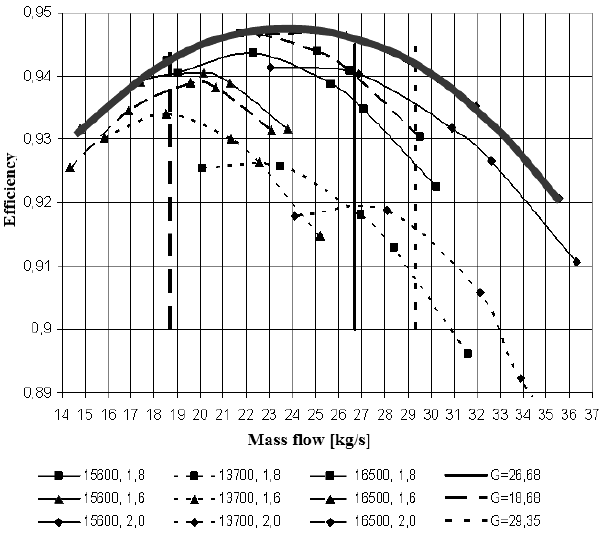
Figure 8. Operating characteristics of the flow part Figure 8: Operating characteristics of the flow part